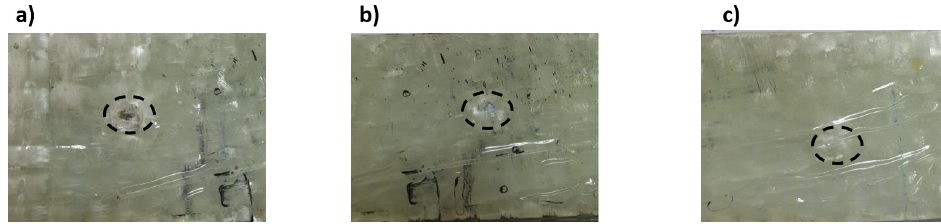
Figure 21. Indentation though GFRP for ( a ) 1.9 J, ( b ) 2.7 J, and ( c ) 3.4 J.